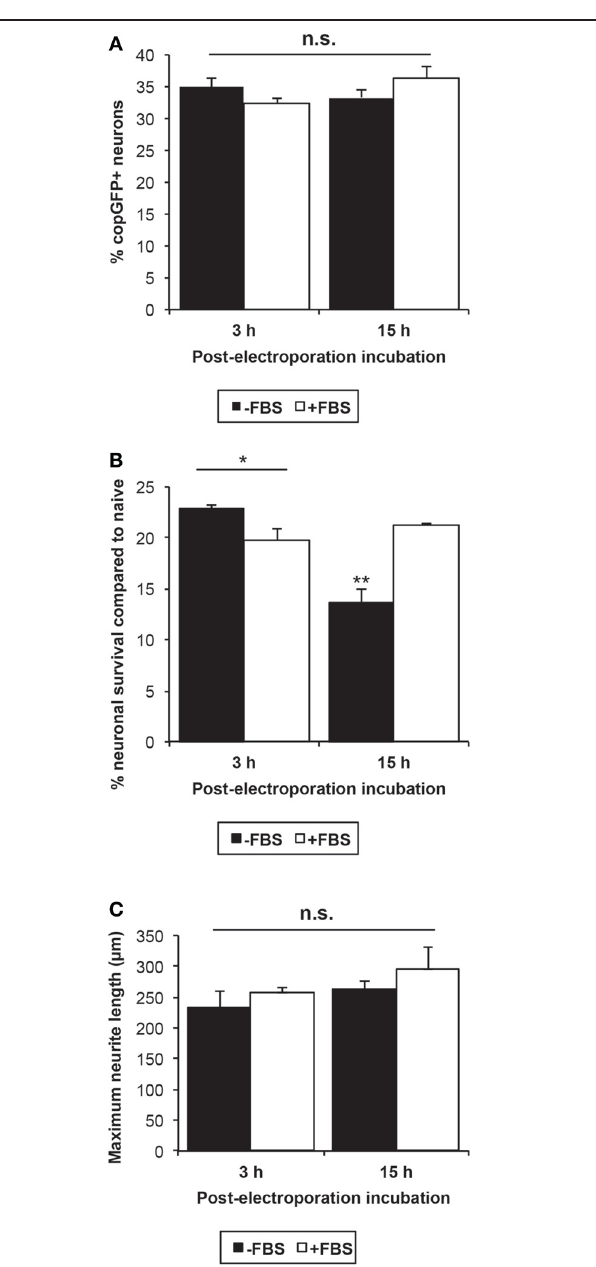
FIGURE 4 | Influence of serum following neuronal transfection. (A) The omission of FBS and a shorter post-electroporation incubation time did not significantly influence the neuronal transfection efficiency at 48h. (B) Neuronal survival was significantly affected by both the presence of serum and the incubation time between electroporation and medium change. Omission of FBS from the medium resulted in significant cell death if medium was not changed until 15h post-electroporation (ANOVA p < 0 . 001, Fisher’s post-hoc analysis; ∗ p < 0 . 05; ∗∗ p < 0 . 01). However, when the medium was changed 3h after the electroporation, the omission of serum did not decrease cell survival. (C) Though no significant difference was detected, neurite length was increased on average by 12% after incubation in serum-containing medium for 3h or 15h, suggesting that even short-term serum exposure stimulates growth-related mechanisms in adult DRG